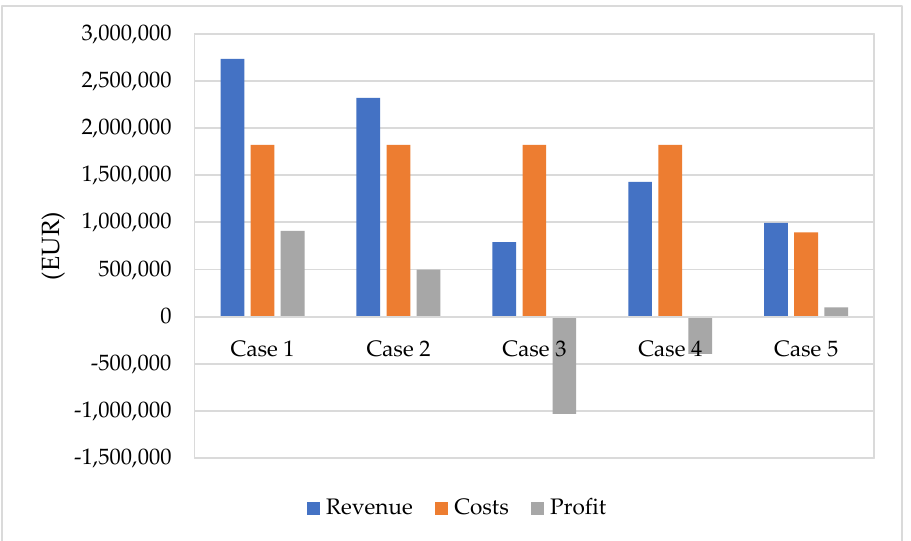
Figure 7. The costs, revenue and profit of the CHP plant.